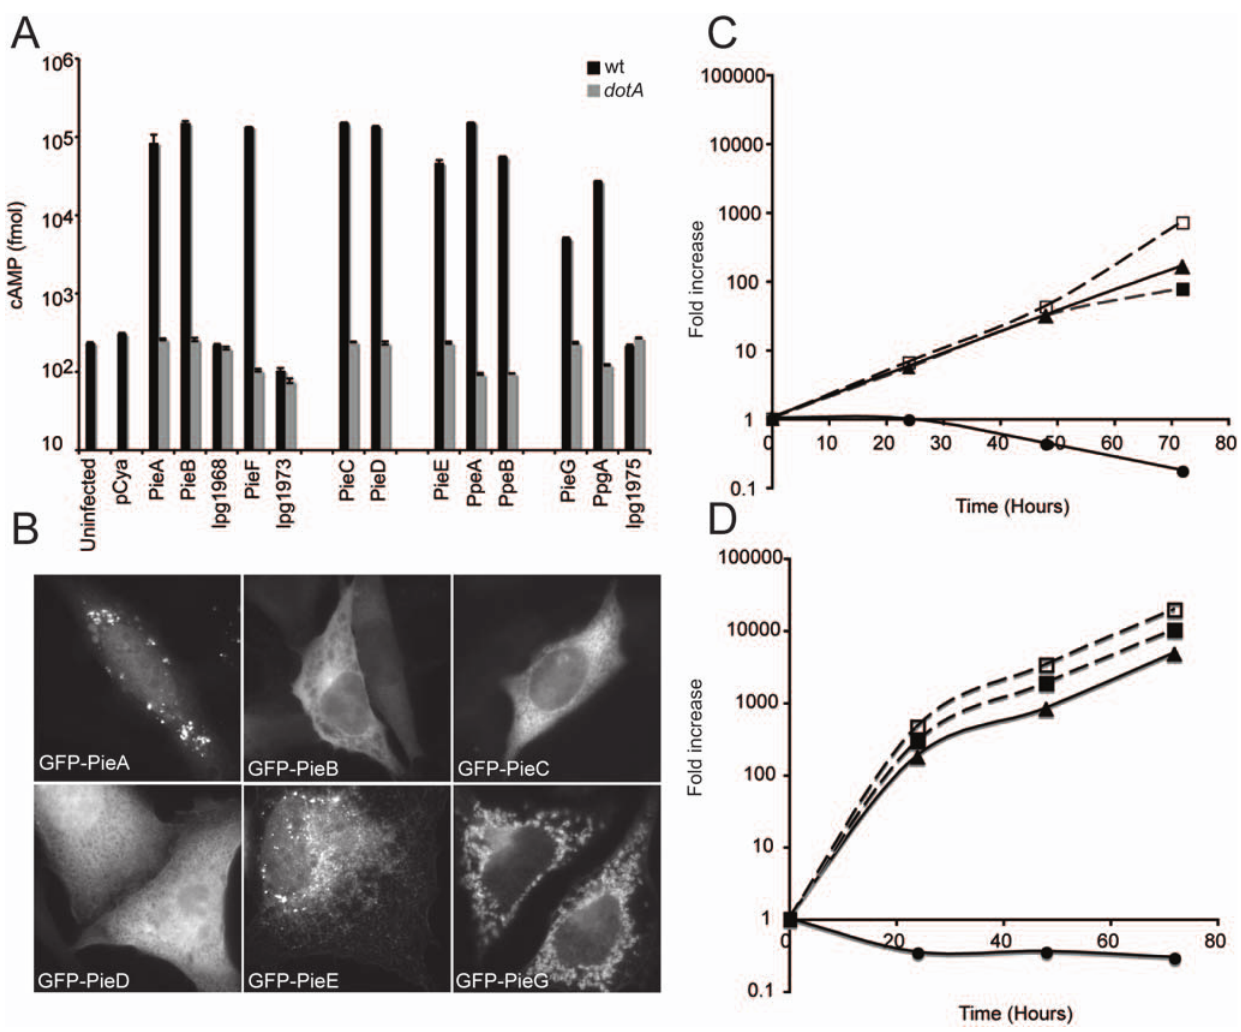
Figure 2. Pie proteins are translocated substrates of the Dot/Icm system and show distinct localization patterns when produced in eukaryotic cells. (A) CHO Fc c RII cells were infected, at an MOI of 30, with L. pneumophila strains wild-type (black bars) or dotA (grey bars) harboring plasmids expressing Cya fusion with the indicated proteins. One hour after infection cells were lysed and cAMP was extracted and quantified as described under Materials and Methods. Levels of cAMP were also determined for uninfected cells (uninfected), or cells expressing Cya alone (pCya). Each bar represents the mean cAMP value obtained from triplicate wells 6 standard deviation. (B) Epifluorescence micrographs of CHO Fc c RII cells expressing the indicated Pie proteins N-terminally fused to GFP, demonstrating unique subcellular distribution phenotypes. (C,D) L. pneumophila growth rates were determined in mouse bone marrow-derived macrophages (C), and in the protozoan host A. castellanii (D). Intracellular growth of strain SN179 (open squares) was compared to that of strain SN178 (closed squares), wild-type L. pneumophila strain Lp01 (triangles), and D dotA mutant strain CR58 (circles). Each time point represents the fold increase in the mean number of viable bacteria recovered from triplicate wells. The Pie proteins were not essential for the intracellular multiplication of L. pneumophila in these cell